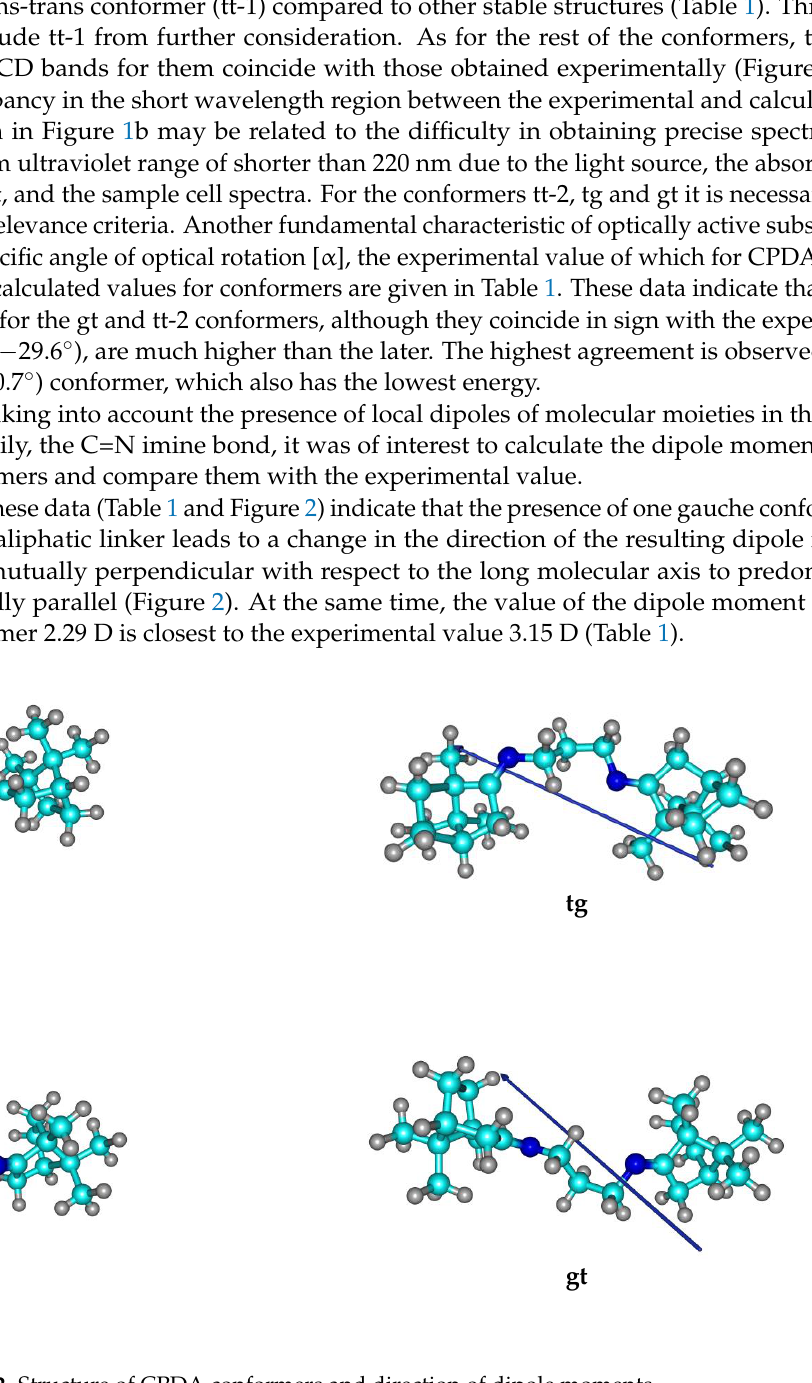
Table 2. 15 N NMR spectrum of CPDA in CDCl 3 and average total deviations of the calculated values of the 1 H and 13 C chemical shifts of the conformers from the experimental ones. Nucleus